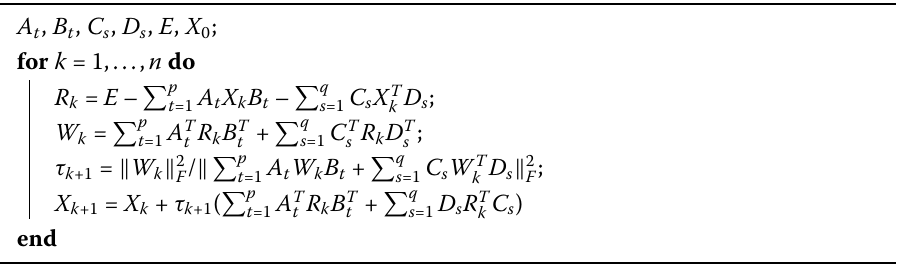
Algorithm 1: The gradient-descent iterative algorithm for Eq.